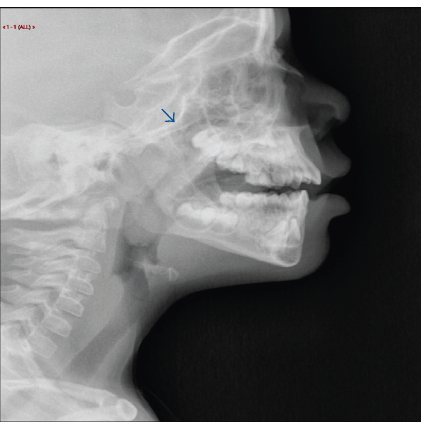
Figure 1: Soft tissue X-ray image showing adenoid enlargement.